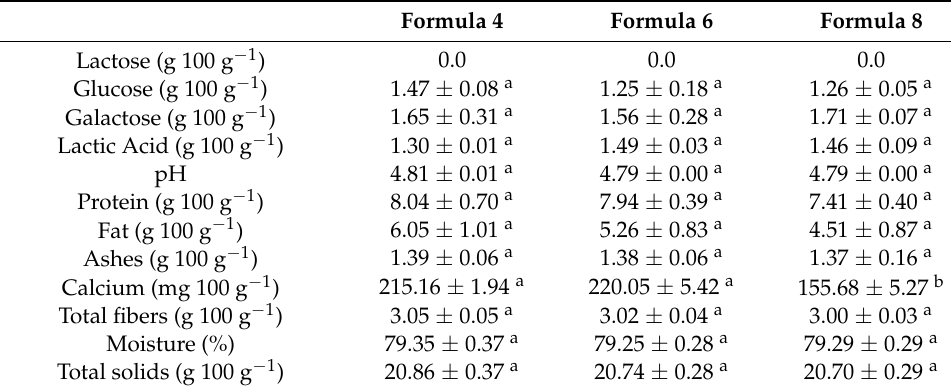
Table 5. Physical-chemical characterization of formulas. Formula 4 Formula 6 Formula